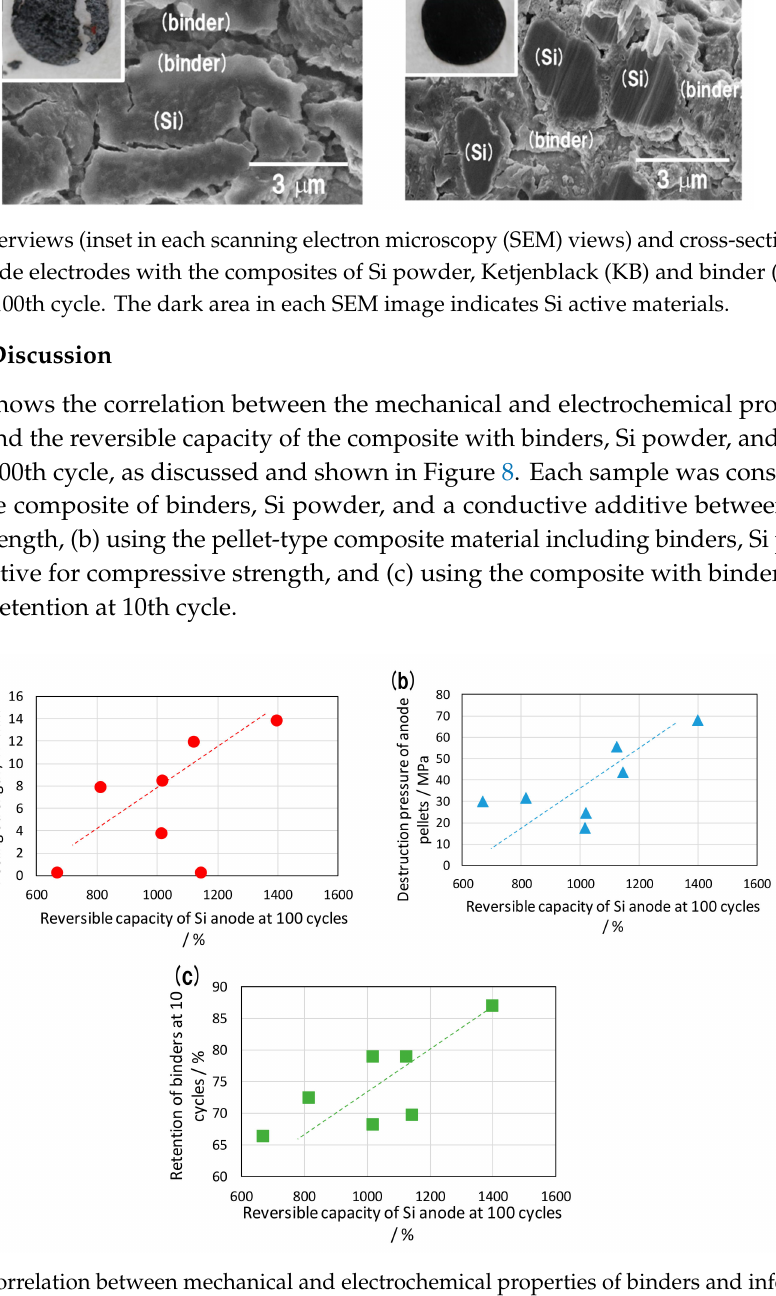
Figure 10. Correlation between mechanical and electrochemical properties of binders and inferiority of cycle property. ( a ) Peeling strength vs. reversible capacity of Figure 8 at 100th cycle. ( b ) Destruction pressure of anode pellets vs. reversible capacity at 100th cycle. ( c ) Retention of binders at 10 cycles vs. reversible capacity at 100th